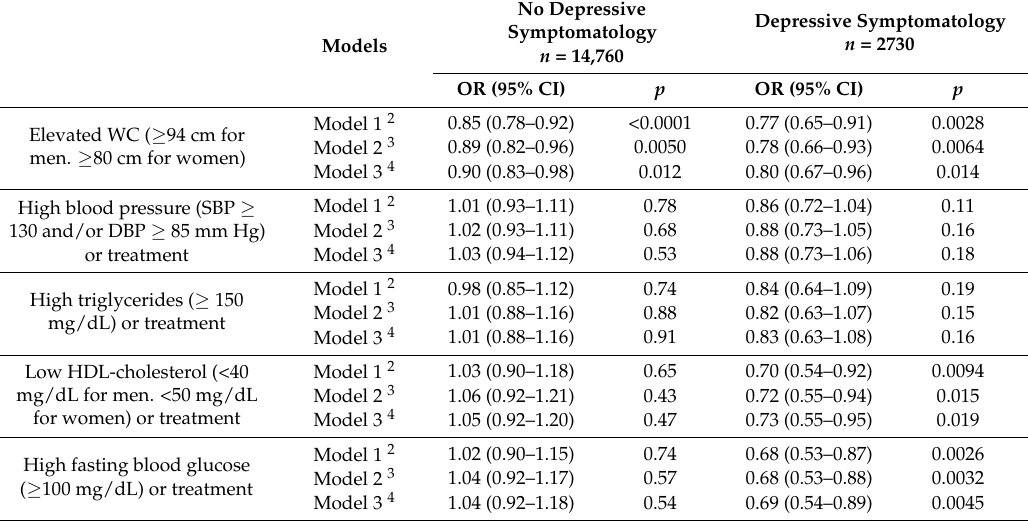
Table 3. Multivariable logistic regression models between overall mindfulness 1 , the metabolic syndrome and its components according to depressive symptomatology in 17,490 individuals (NutriNet-Sant é Study, France,